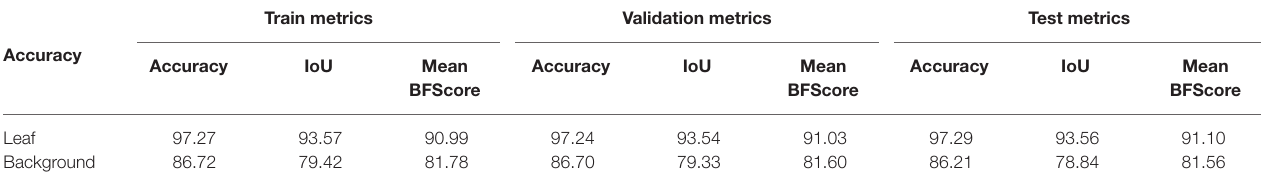
TABLE 8 | The intersection over union (IoU) and BFScore for each class.